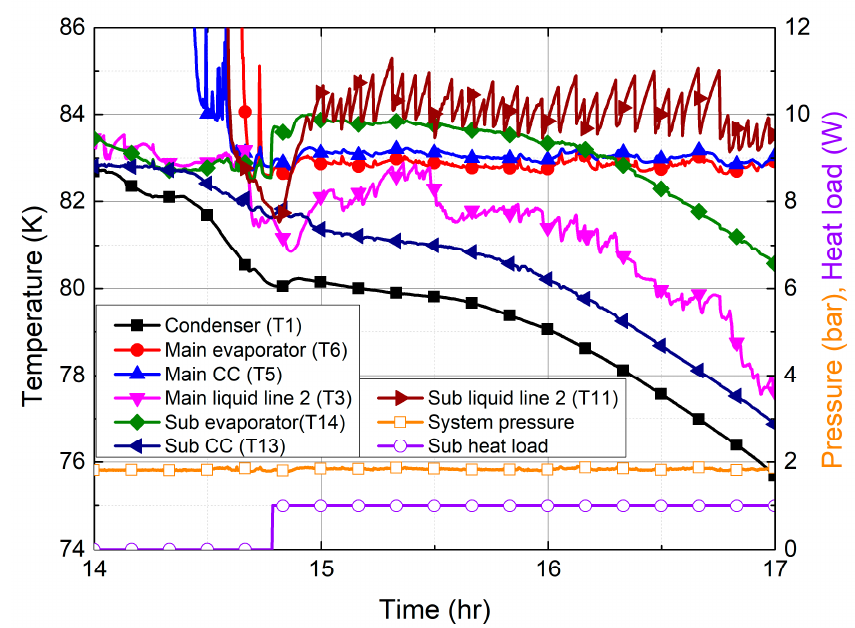
Figure 8. Change in the CLHP internal temperature and pressure when the subloop was circulated to a heat load of 1 W after the main CC was sufficiently filled with